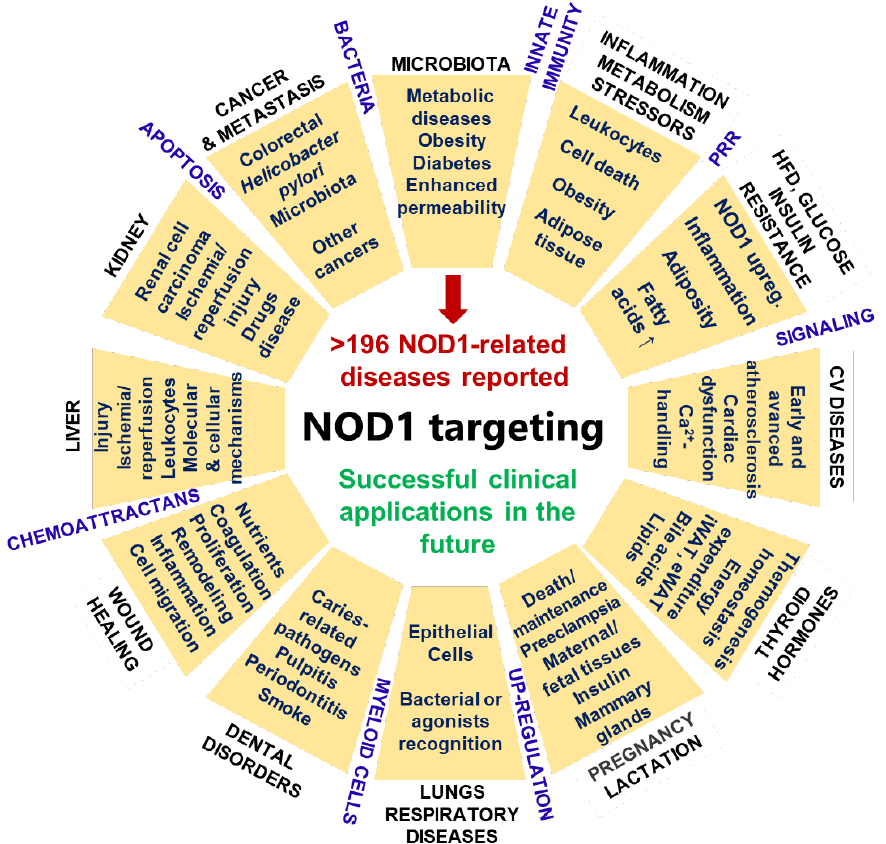
Figure 3. Health or disease: a matter of the well-known PRR NOD1 with possibilities of taking advantage of alliances with immunonutrition. NOD1, a cytoplasmic PRR of the innate immunity, is expressed in nonhematopoietic cells (such as endothelia) and in hematopoietic and immune cells (e.g., monocytes/macrophages, neutrophils, NK cells, lymphocytes). PRRs recognize molecular patterns associated with microbes or pathogens (MAMPs or PAMPs) and become activated. Impairments in this activation lead to the development of autoimmunity and other diseases. Components of the bacterial cell wall (peptidoglycan (PGN) and murein), are recognized and activate NOD1. γ-D-glutamyl- meso -diaminopimelic acid (iE-DAP) is sufficient to accomplish NOD1 activation. iE-DAP is mainly present in Gram-negative bacteria, which constitute the main microorgan- isms in the human gut. There exist at least 196 reported diseases related to NOD1, ranging from several cancers or neoplasms to metabolic, inflammatory, immune, and infectious diseases, as summarized in this figure. NOD1 is overexpressed and activated under these pathological condi- tions. Therefore, NOD1-related diseases connected with nutrient metabolism, deficiencies, or dis- orders can benefit from carefully studied immunonutrition approaches and clinical applications.